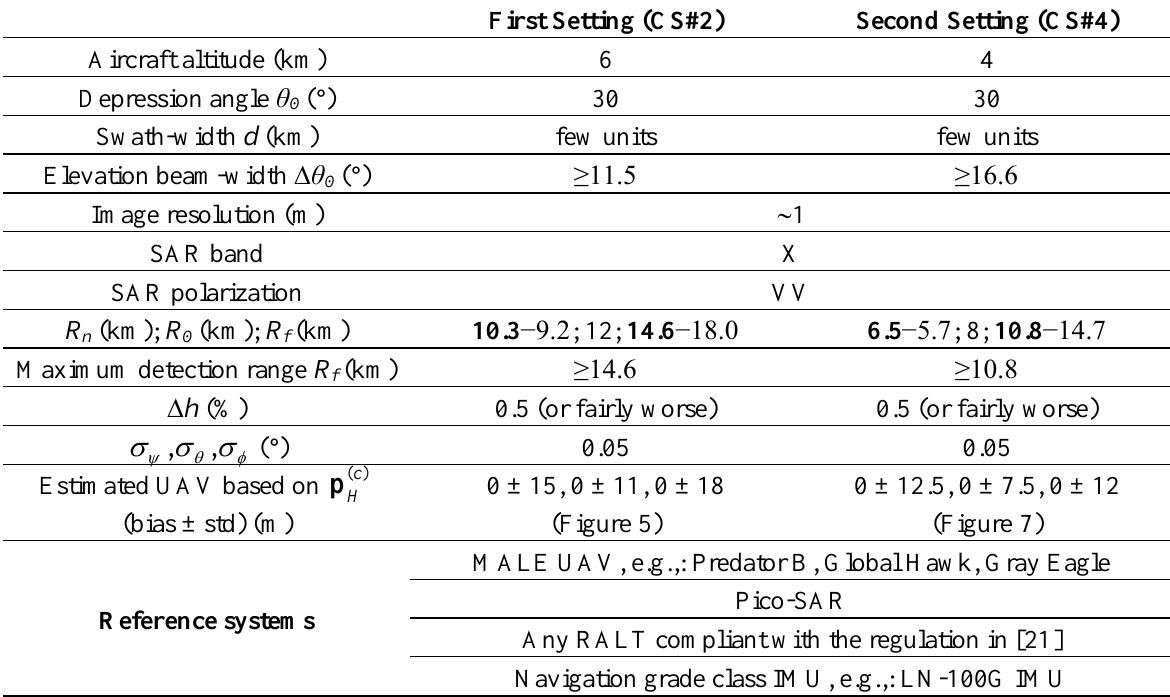
Table 3. Platform, viewing geometry, navigation sensor requirements and corresponding reference system which allows a feasible SAR position retrieval: first trade-off